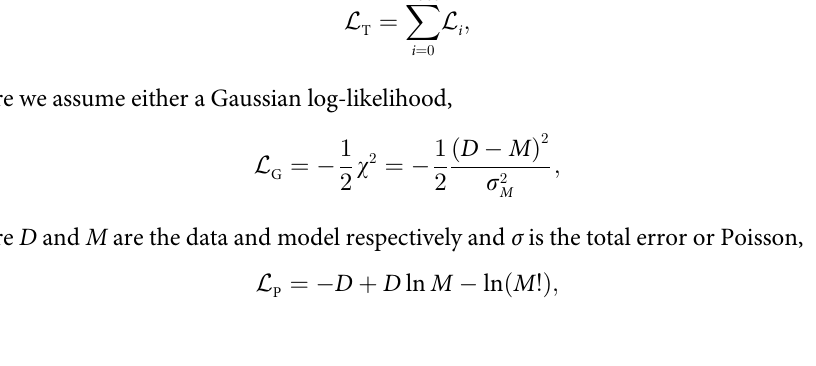
− 2.75 best fits the data.